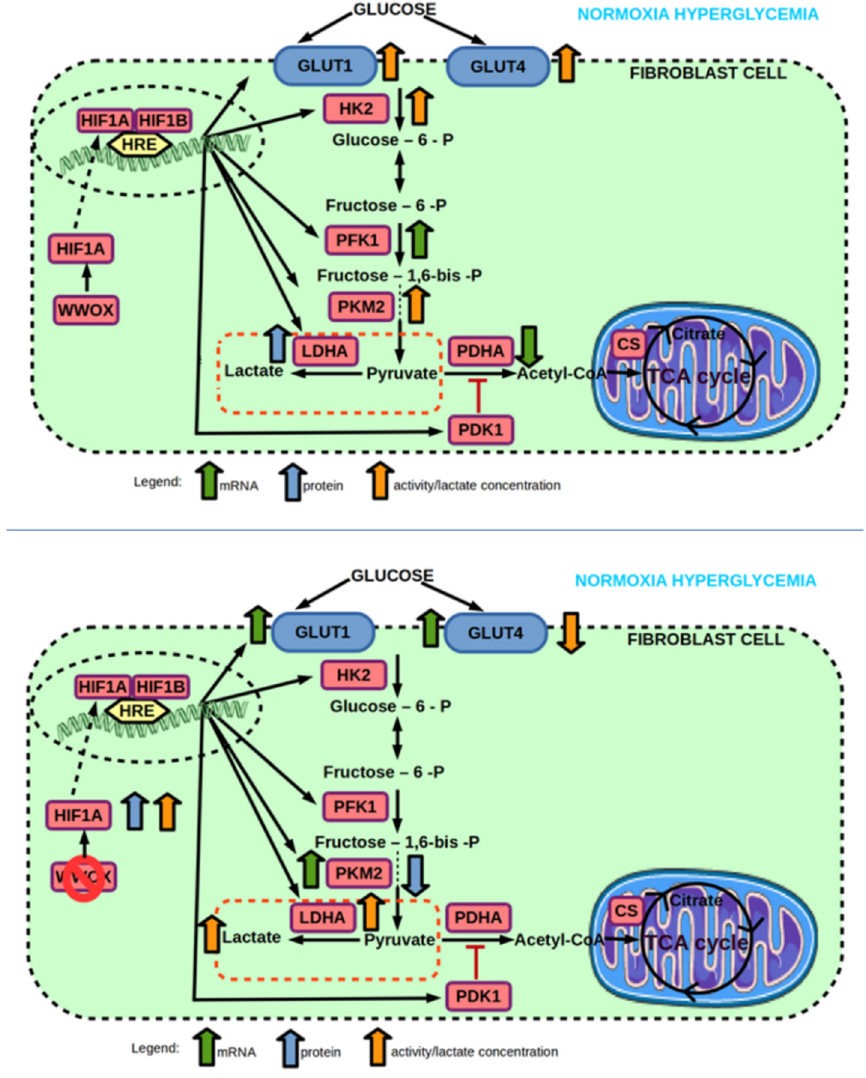
Figure 10. ( top ) Effect of hyperglycemia on mRNA and protein expression, and enzyme activity of genes involved in glucose transport and glycolysis pathway of 1BR.3.N fibroblast cell line in normoxia. ( bottom ) Effect of WWOX KO on mRNA and protein expression, and enzyme activity of genes involved in glucose transport and glycolysis pathway of 1BR.3.N fibroblast cell line in normoxia hyperglycemia condition. Based on free images from Servier Medical Art; CC BY 3.0.